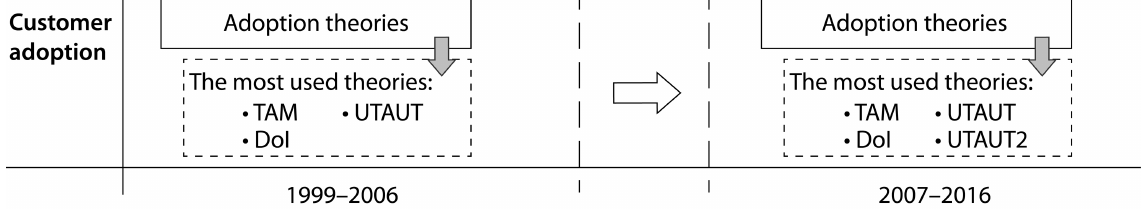
Fig. 8. Dynamic of theoretical base evolution within customer adoption theme.